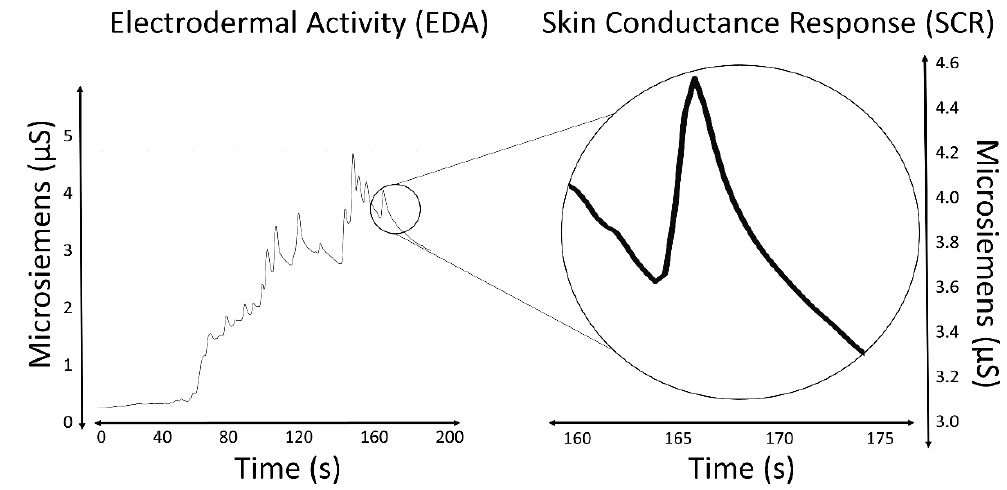
Figure 1. EDA signal and an isolated SCR.